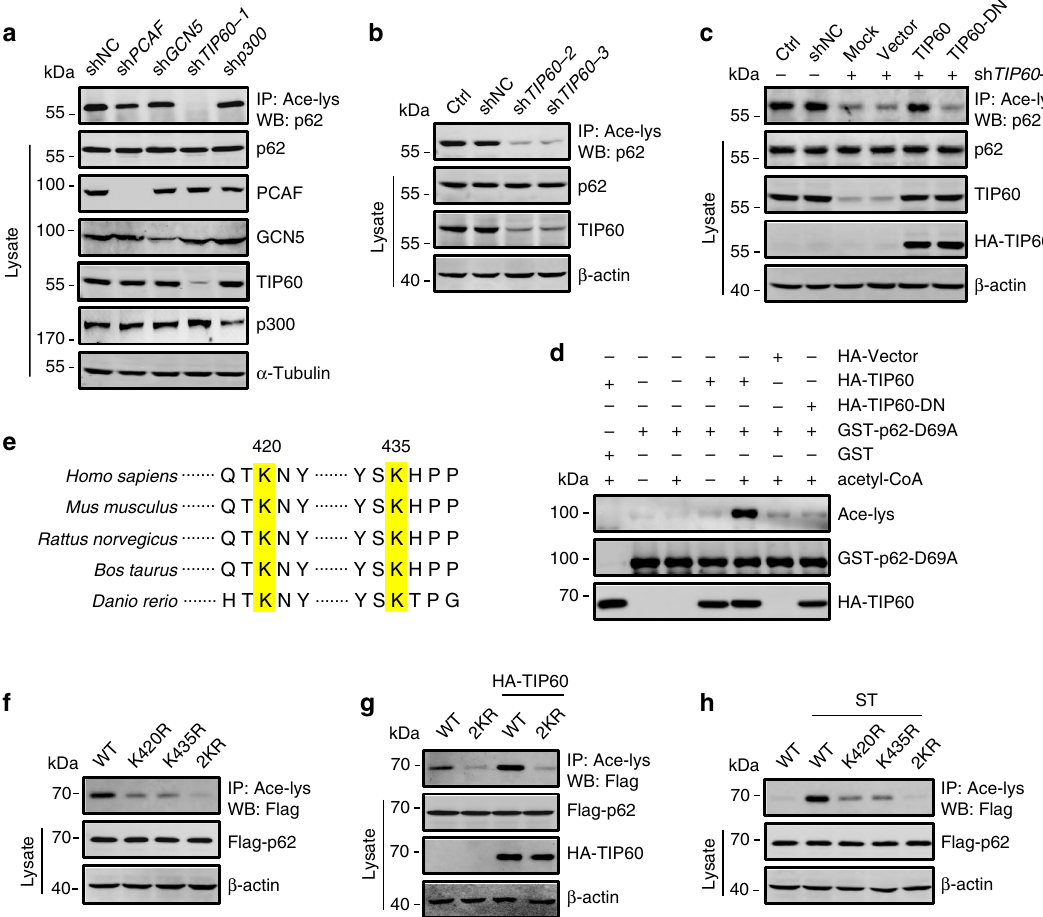
Fig. 3 TIP60 acetylates p62 at K420 and K435. a – c Acetylation of p62 in HeLa cells infected with lentivirus expressing each of the indicated acetyltransferase shRNAs ( a , b ) and with HA-TIP60 or HA-TIP60-DN transfection 48h after TIP60 shRNA infection ( c ). d In vitro p62 acetylation assay. Puri fi ed GST-p62-D69A from E. coli was incubated with HA-TIP60 or HA-TIP60-DN immunoprecipitated from HEK293T cells, in the presence or absence of acetyl-CoA. p62 acetylation was analyzed by western blot using anti-acety-lys. e Alignment of p62 amino acid sequence from various species. Yellow shading indicates the conserved K420 and K435. f – h Acetylation of p62 mutants expressed in HeLa cells ( f , g ) or HEK293 cells ( h ). The cells were transfected with or without HA-TIP60 ( g ), or treated with or without starvation ( h ). 2KR, both Lys420 and Lys435 residues were replaced by Arg. Source data are provided as Source Data fi